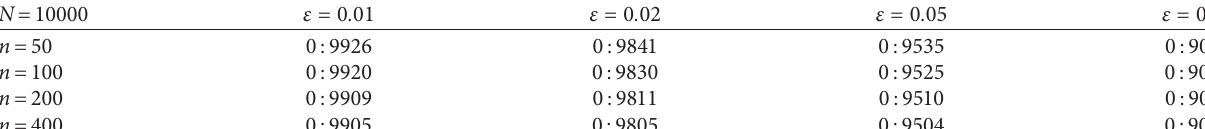
Table 11: Empirical levels and corresponding theoretical levels ( ε � 0 . 01 , 0 . 02 , 0 . 05 , 0 . 10 ) .